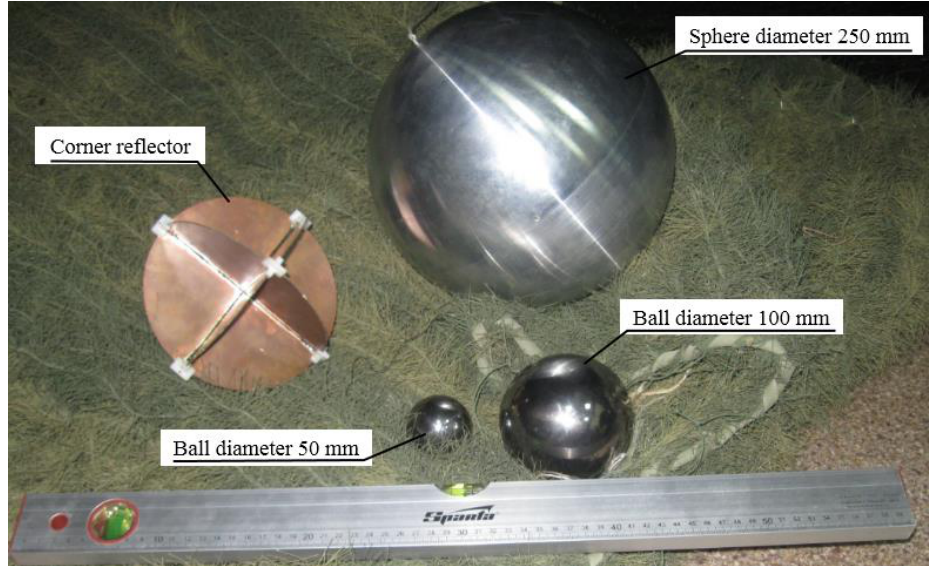
Fig. 4. Reflected signal time domain diagram without parametric reflector, made with the measuring bench.